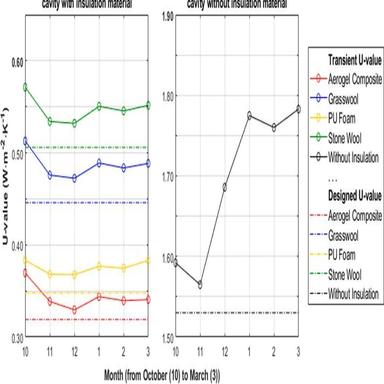
Transient Thermal Transmittance (U-Value) for the masonry wall with aerogel composite, reference materials and original construction in the heating period (October to March).